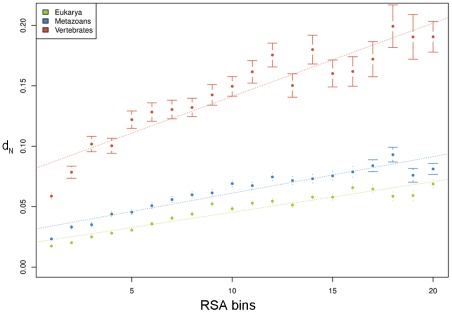
Linear relationship between solvent accessibility and d
N in Eukarya, Metazoans and Vertebrates age groups.Eukarya: Pearson correlation: 0.957, p-value = 4.477e−11; Metazoans: Pearson correlation: 0.950, p-value = 1.445e−10; Vertebrates: Pearson correlation: 0.941, p-value = 7.005e−10. Errors bars indicate the standard error for the d
N calculation.